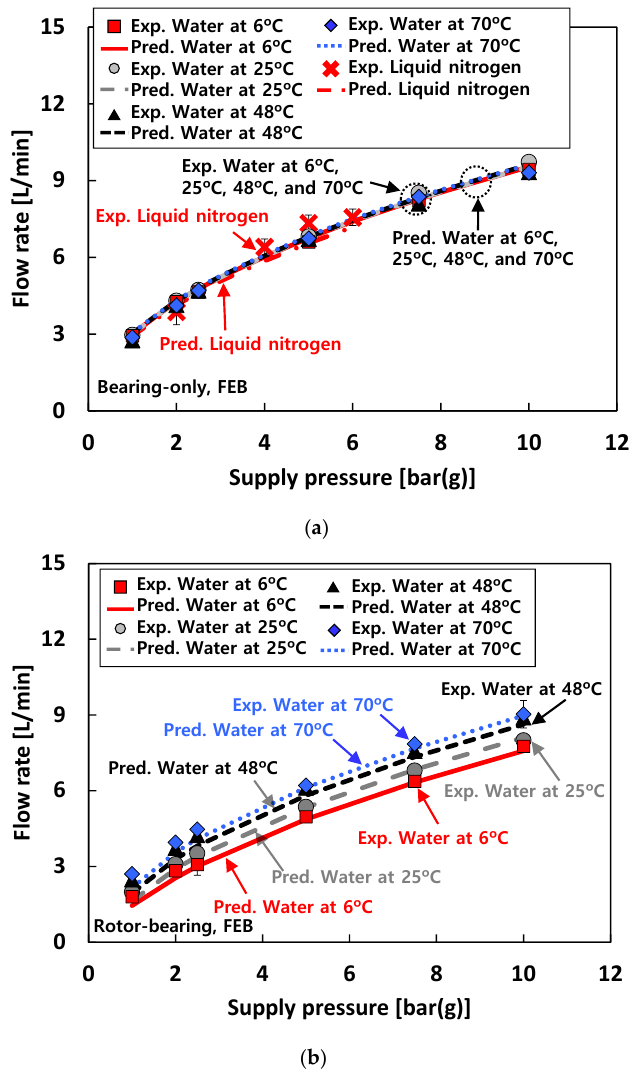
Figure 13. Predictions versus measurements. Test cases #2 and #3: bearing flow rate of free end bearing (FEB). ( a ) Bearing-only condition. ( b ) Rotor-bearing condition. Figure 14 compares the predicted and the measured eccentricity ratios of the free end bearing for test cases #1 through #3. The predicted eccentricity ratios noticeably decrease with P s . For test case #1 (i.e., tests with air), the predicted eccentricity ratios agree well with the test data. For test case #2 (i.e., tests with water), correlations between measure- ments and predictions become less favorable as the water temperature increases while those for 6 °C water are remarkable. For test case #3 (i.e., tests with liquid nitrogen), the predictions show a good agreement with the measurements even though the predicted eccentricity ratios are slightly larger than the test data. ( a )